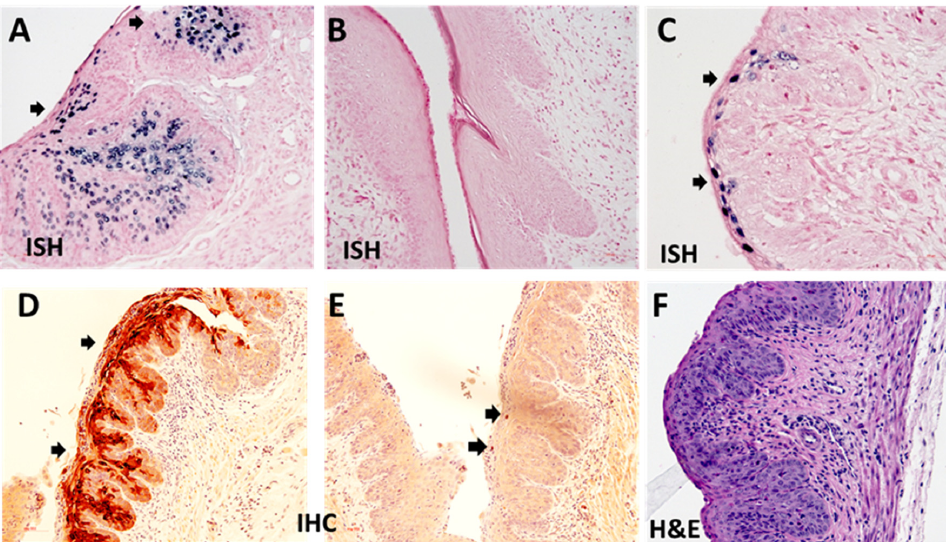
Figure 3. Increased viral activities were detected in the lower genital tissues of Depo medroxypro- gesterone (DMPA) treated Nu/J heterozygous (Foxn1 nu/+ ) mice. Vaginal tissues from female athymic HsD:Nu ( A ), Nu/J heterozygous mice (Foxn1 nu/+ ) either treated with PMSG ( B ) or DMPA ( C ) and infected with MmuPV1 were further tested for viral presence by in situ hybridization (ISH, A – C ) and immunohistochemistry (IHC, D , E ). Viral DNA could be readily detected in the infected vaginal tract of athymic mice ( A , in blue as arrows pointed, 20×) but not in PMSG treated mice that were negative for viral DNA ( B , 20×). Viral activities were also detected in the infected vaginal tissues of DMPA treated NU/J (Foxn1 nu/+ ) mice ( C , in blue as arrows pointed, 40×). The DMPA treated mice were also positive for MmuPV1 E4 ( C , in red as arrows pointed, 20×) and capsid L1 ( C , in blue as arrows pointed, 20×, arrows) suggesting productive infections occurred in these DMPA treated mice. Mild dysplasia was detected in the infected vaginal tissues of DMPA treated mice ( F , 40×).